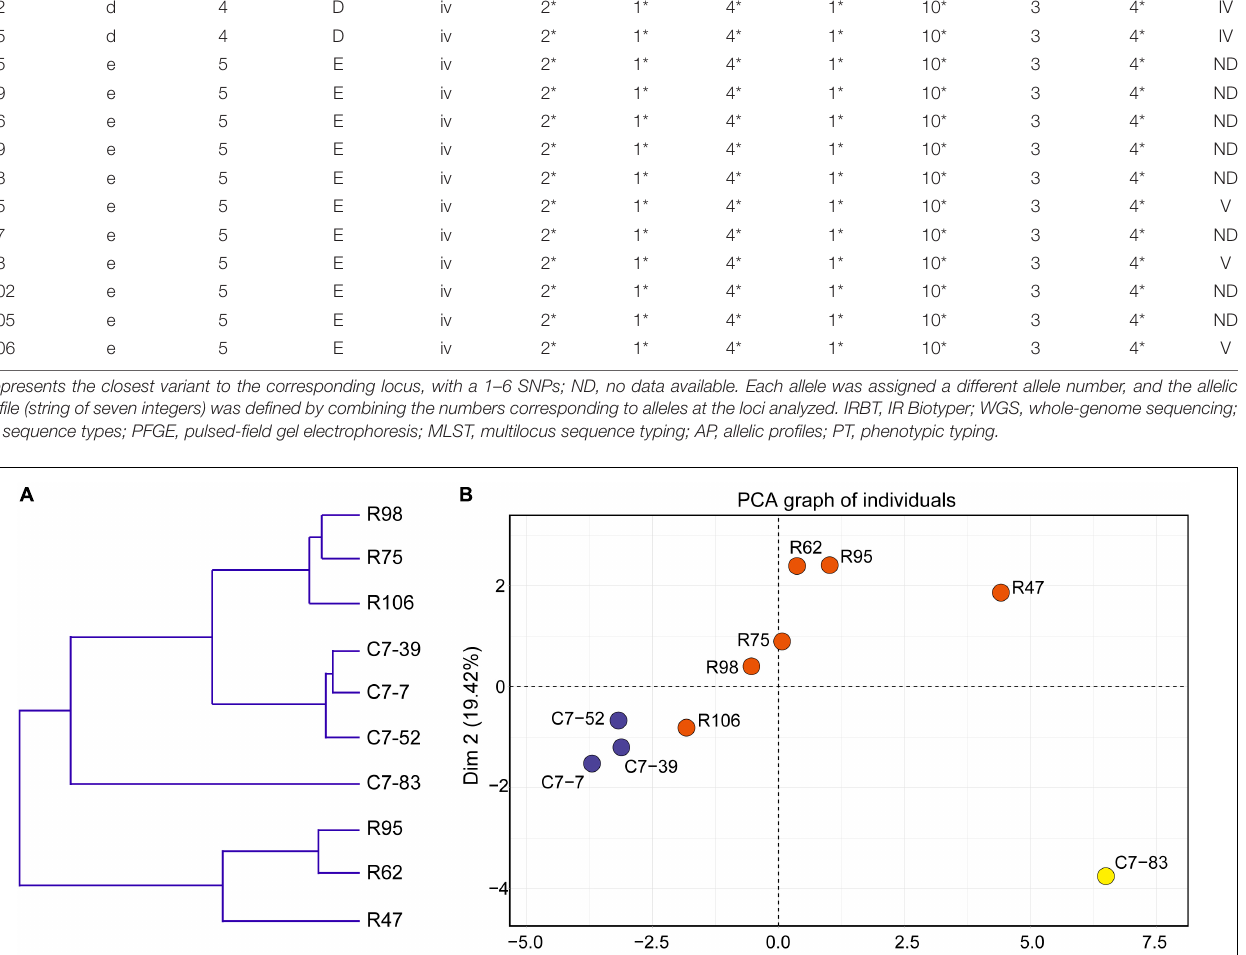
Allele no. at locus